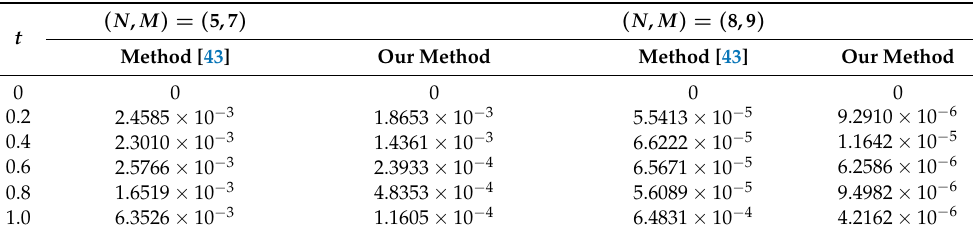
Table 7. Comparison of the estimated absolute errors for various values of N and M for ν = 0.9 of Equation (33) to ξ = 0.5, η = 1.